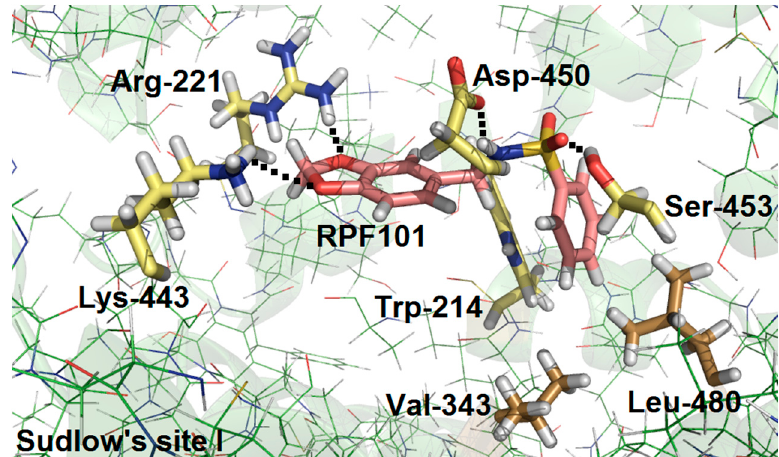
Figure 8. The best score pose for the interaction HSA: RPF101 in Sudlow’s site I, as obtained by molecular docking ( ChemPLP function). RPF101 structure, selected hydrophilic and hydrophobic amino acid residues are represented in beige, yellow and brown, respectively. Green color is the HSA structure (PDB:1N5U). Elements colors: hydrogen, oxygen, nitrogen, and sulfur are represented in white, red, blue, and goldenrod, respectively. Arginine: Arg; aspartic acid: Asp; lysine: Lys; tryptophan: Trp; serine: Ser; leucine: Leu; valine: Val.